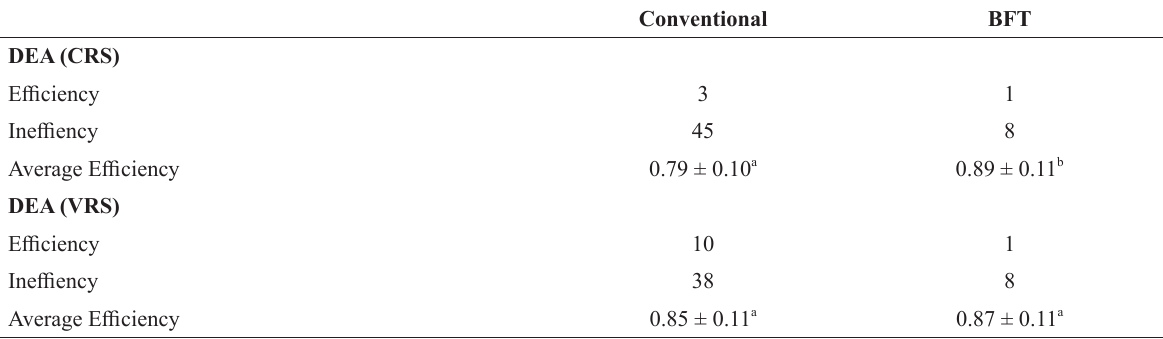
Technical efficiency results obtained through data envelopment analysis (DEA) with constant (CRS) and variable returns to scale (VRS) of the production cycles in conventional and biofloc (BFT) systems held in 2014 in a farm located on the coast of Pernambuco,